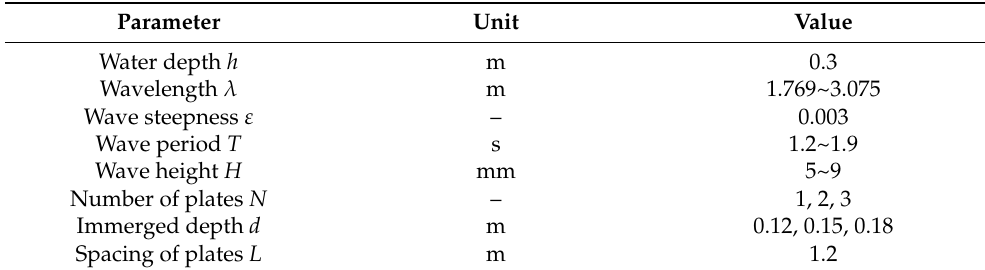
Table 4. Experimental parameters of multiple vertical rigid